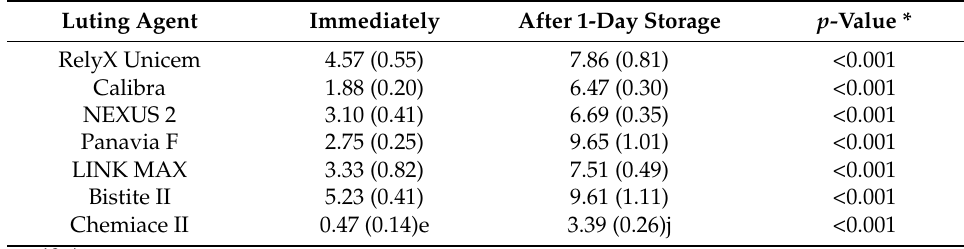
Table 3. Flexural modulus of luting-agents (GPa, mean (S.D.)). Luting Agent Immediately After 1-Day Storage p- Value * RelyX Unicem 4.57 (0.55) <0.001 Calibra NEXUS